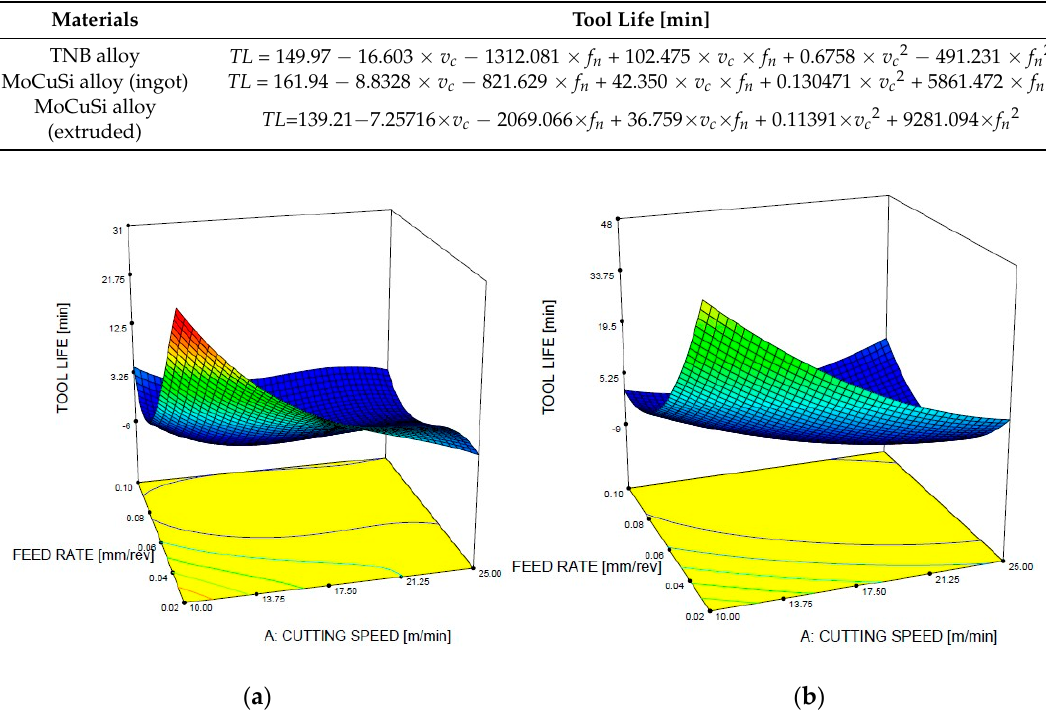
Table 3. Tool life estimation from ANOVA analysis.